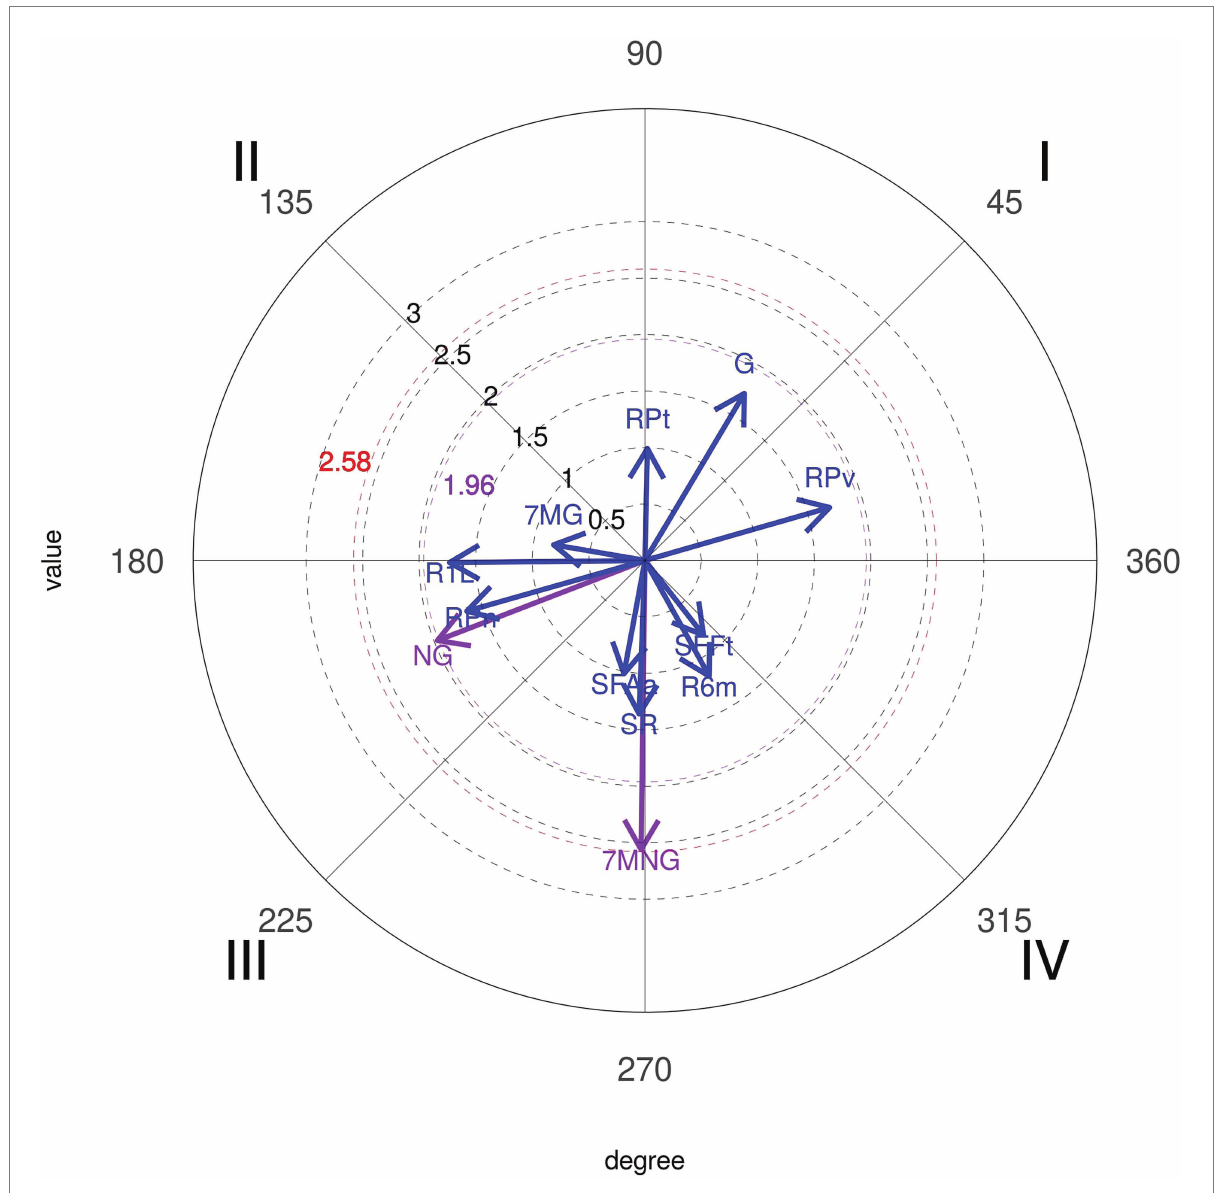
FIGURE 12 Polar coordinate analysis map: focal conduct “All National Teams.” Conditioned conducts: NG, no goal; 7MNG, 7 m no